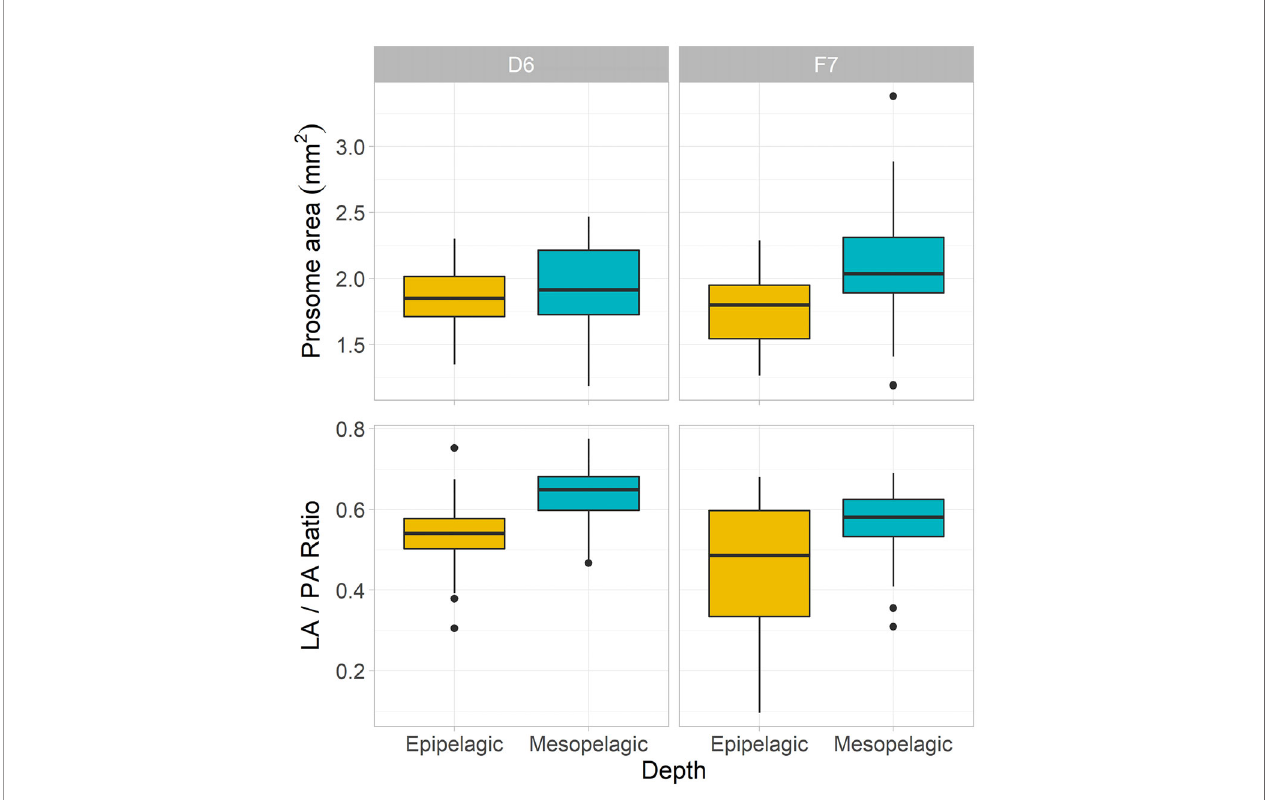
FIGURE 2 | Morphometric characteristics of C. fi nmarchicus CV from epipelagic (yellow) and mesopelagic (blue-green) depths at slope station D6 and basin station F7. Boxplots of mean prosome area (PA) and lipid sac to prosome area (LA/PA) ratios per depth and station (box shows interquartile range around the median as the horizontal line, with black circles representing